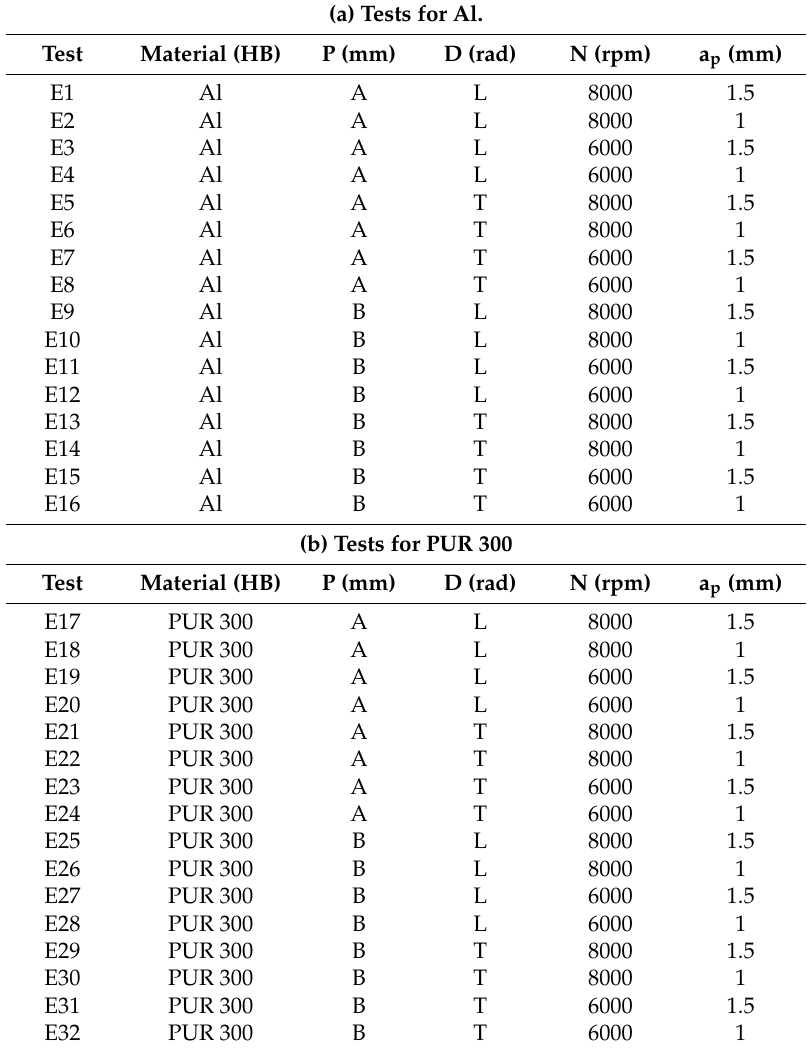
Table 3. ( a ) Tests for Al. ( b ) Tests for PUR 300. (a) Tests for